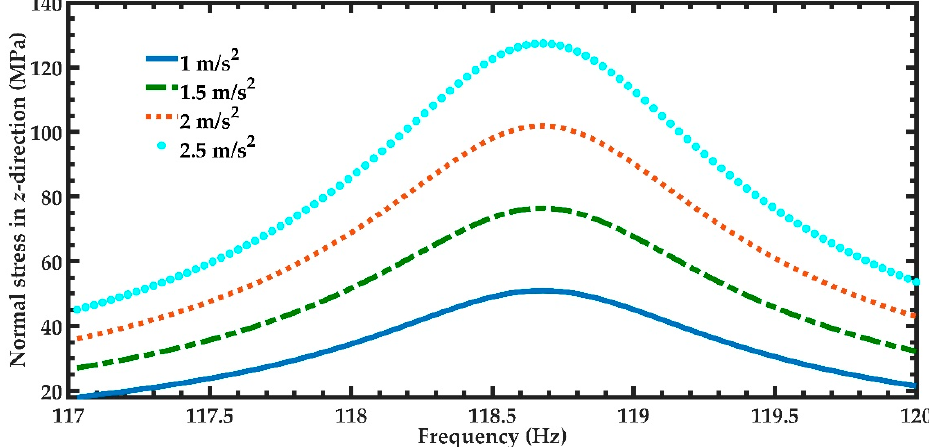
Figure 16. Maximum normal stress in z -direction of the nanogenerator regarding four different accelerations in y -direction and a frequency range from 117 to 120 Hz.